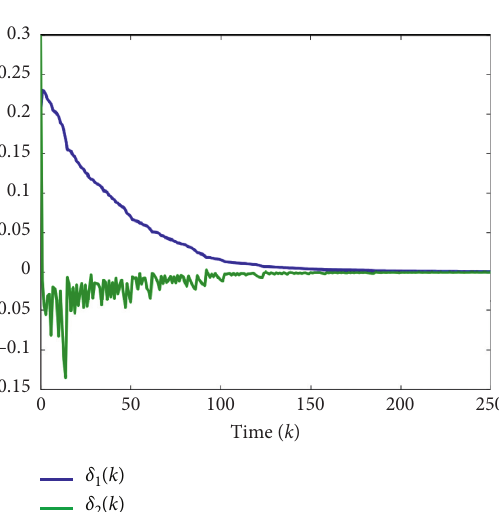
Figure 7: Controller mode.